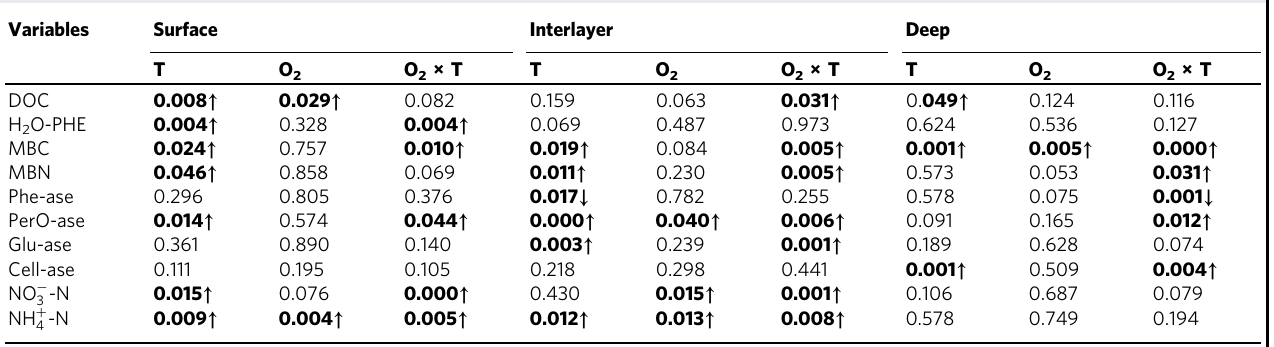
Signi fi cance values refer to a t -test between control and treatments. Bold denotes signi fi cant variation; ↑ and ↓ denote signi fi cant increases or decreases relative to the control. T warming, O 2 oxic conditions, O 2 × T oxic conditions with warming, DOC dissolved organic carbon, H 2 O-PHE water-soluble phenolics, MBC microbial biomass carbon, MBN microbial biomass nitrogen, Phe-ase phenolic oxidase, PerO-ase peroxidase, Glu-ase β − 1-4-glucosidase, Cell-ase